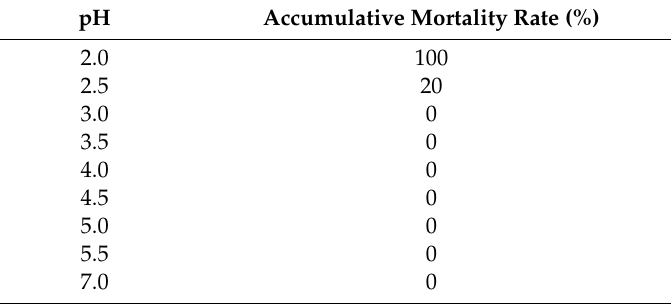
Figure 3. Behavior of adult Eisenia fetida in soil under acid rain with eight pH levels for 15 days ( n = 10). Treatments: pH 7.0: control, pH 2.0–5.5: acid rain with different pH values. Percentages indicate the number of earthworms with the symptom. Table 2. Accumulative mortality of adult Eisenia fetida in soil under acid rain with eight pH levels for